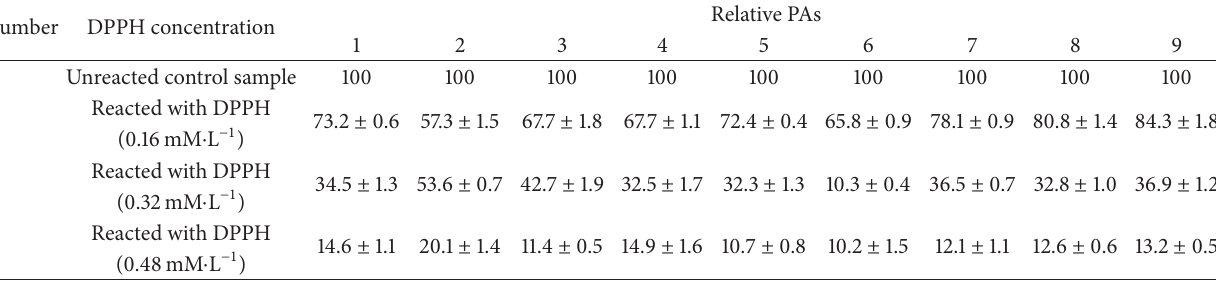
Table 2: Relative PAs of nine peaks after being reacted with different concentrations of